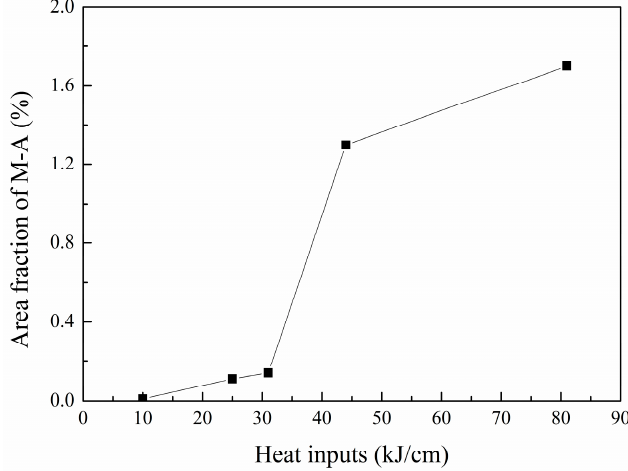
Figure 11. Area fraction of M-A at different heat input.